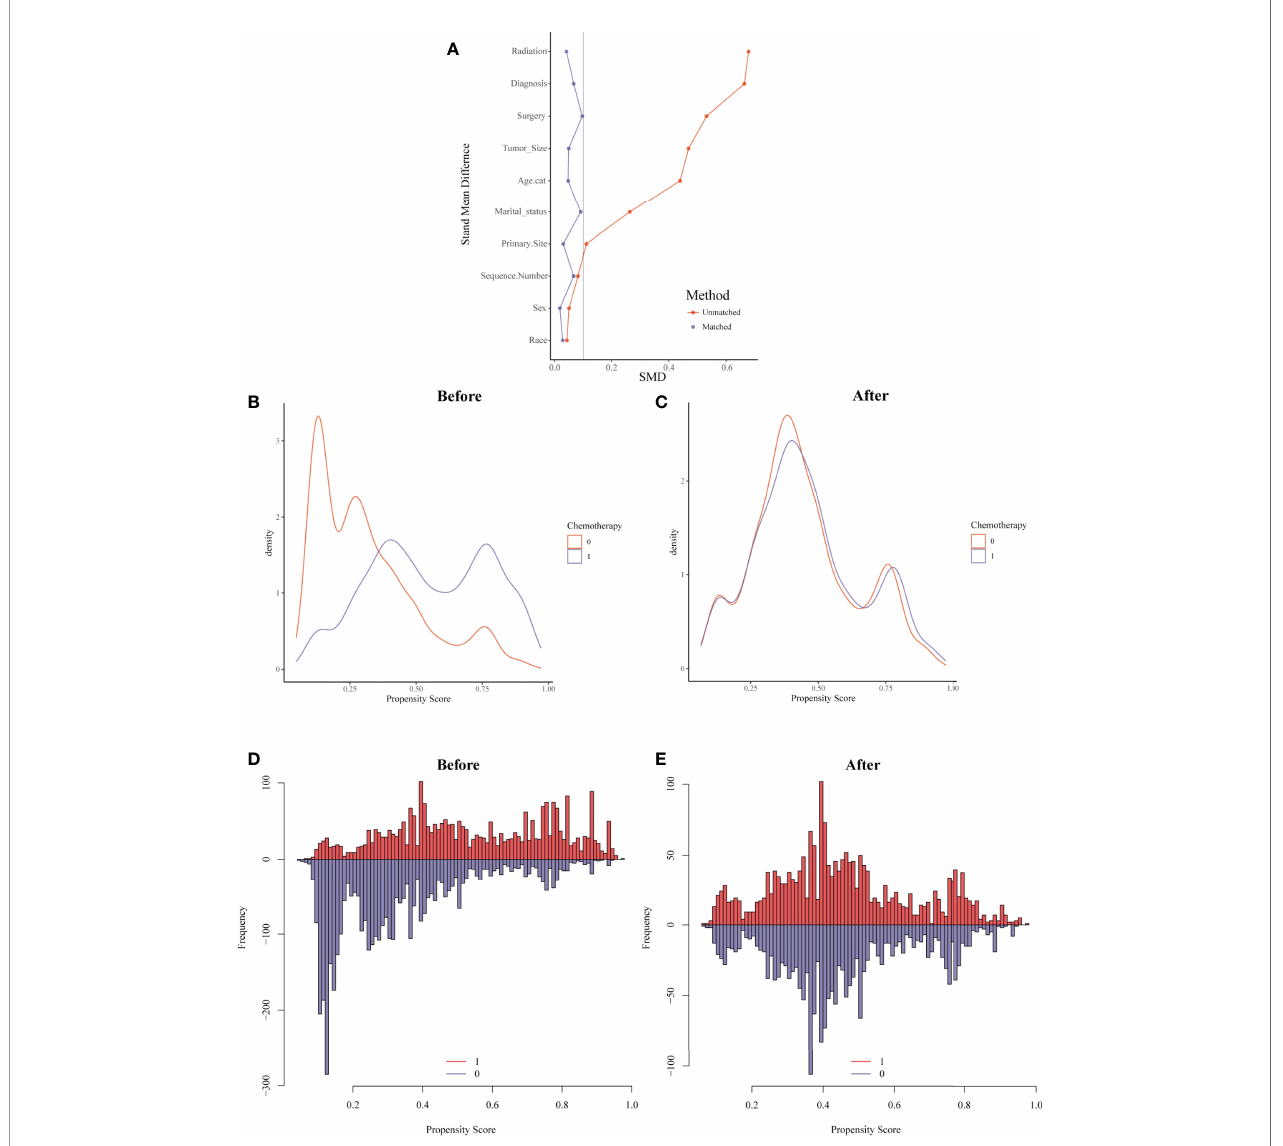
FIGURE 5 | Evaluation of the covariate balance by propensity score matching (PSM). (A) The loveplot showed SMD across covariates before and after PSM. (B, C) Kernel density showed the distribution balance of chemotherapy and non-chemotherapy groups (B) before PSM and (C) after PSM. (D, E) Histogram showed the balance of the chemotherapy group and non-chemotherapy group (D) before PSM and (E) after